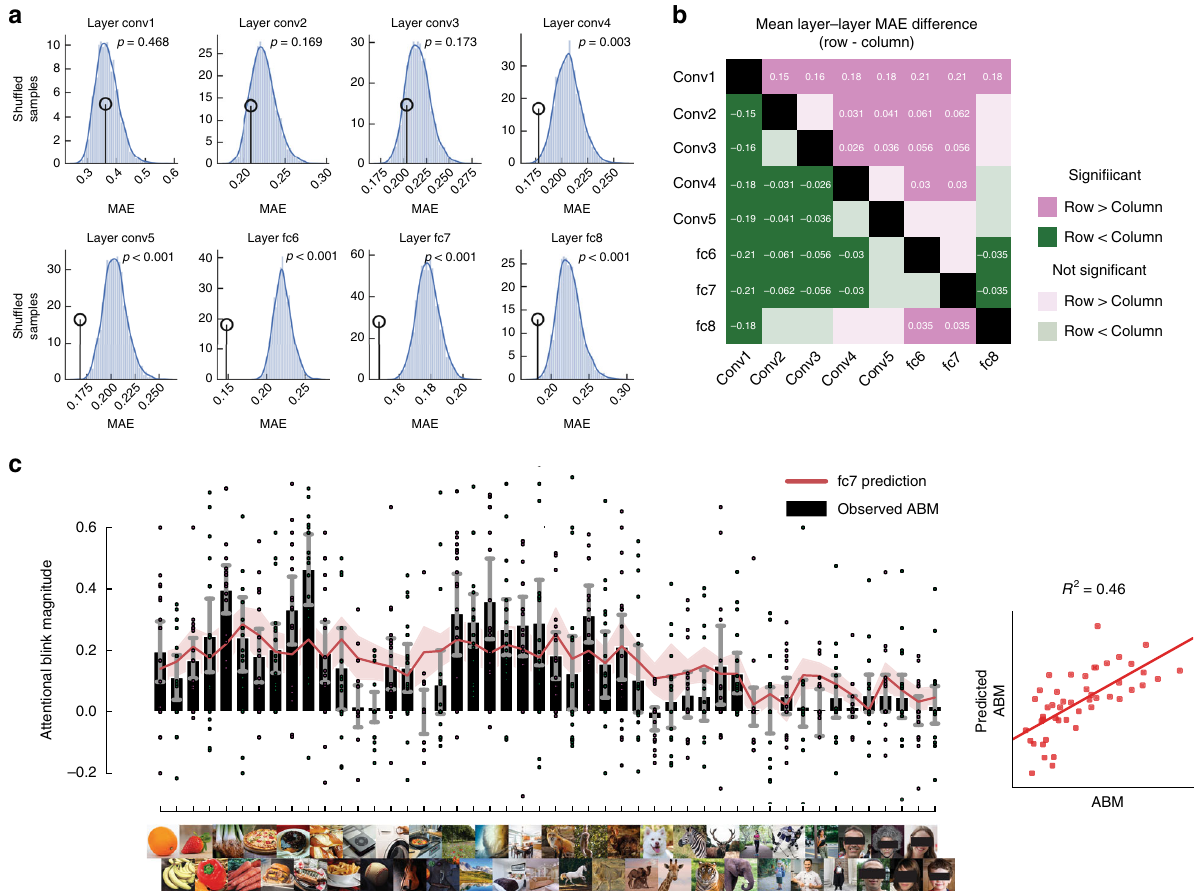
Fig. 3 DCNN activation units predict attentional blink magnitude. a Permutation test distributions. Histograms show the mean absolute error (MAE) after averaging the prediction across participants with randomised image labels. Circles point to the observed MAE. The Bonferroni-corrected alpha value for 8 tests is p < 0.00625. b Layer by layer comparisons of MAE. Comparisons are done row-wise, where green indicates a lower MAE, or better fi t, in comparison to the corresponding column. Only signi fi cant (Bonferroni corrected) comparisons are denoted with mean difference in MAE between comparisons. c ABM per image. Due to copyright reasons, all photos except for the faces (which were photographed by one of the authors) have been replaced by representational images. Eye regions are occluded in the images to protect privacy but were not occluded in the experiment. Black bars indicate the observed Attentional blink magnitude (ABM), red line is the average predicted ABM based on features from Layer fc7 (which outperformed all other layers, see panel b ). Individual dots represent individual participants and error bars indicate the 95% con fi dence interval. Layer fc7 explained 46% of the variance observed. The inset panel shows the average predicted ABM on the y axis, and the average observed ABM per image, on the x signi fi cant main effect for both category (F(1,23) = 20.68,